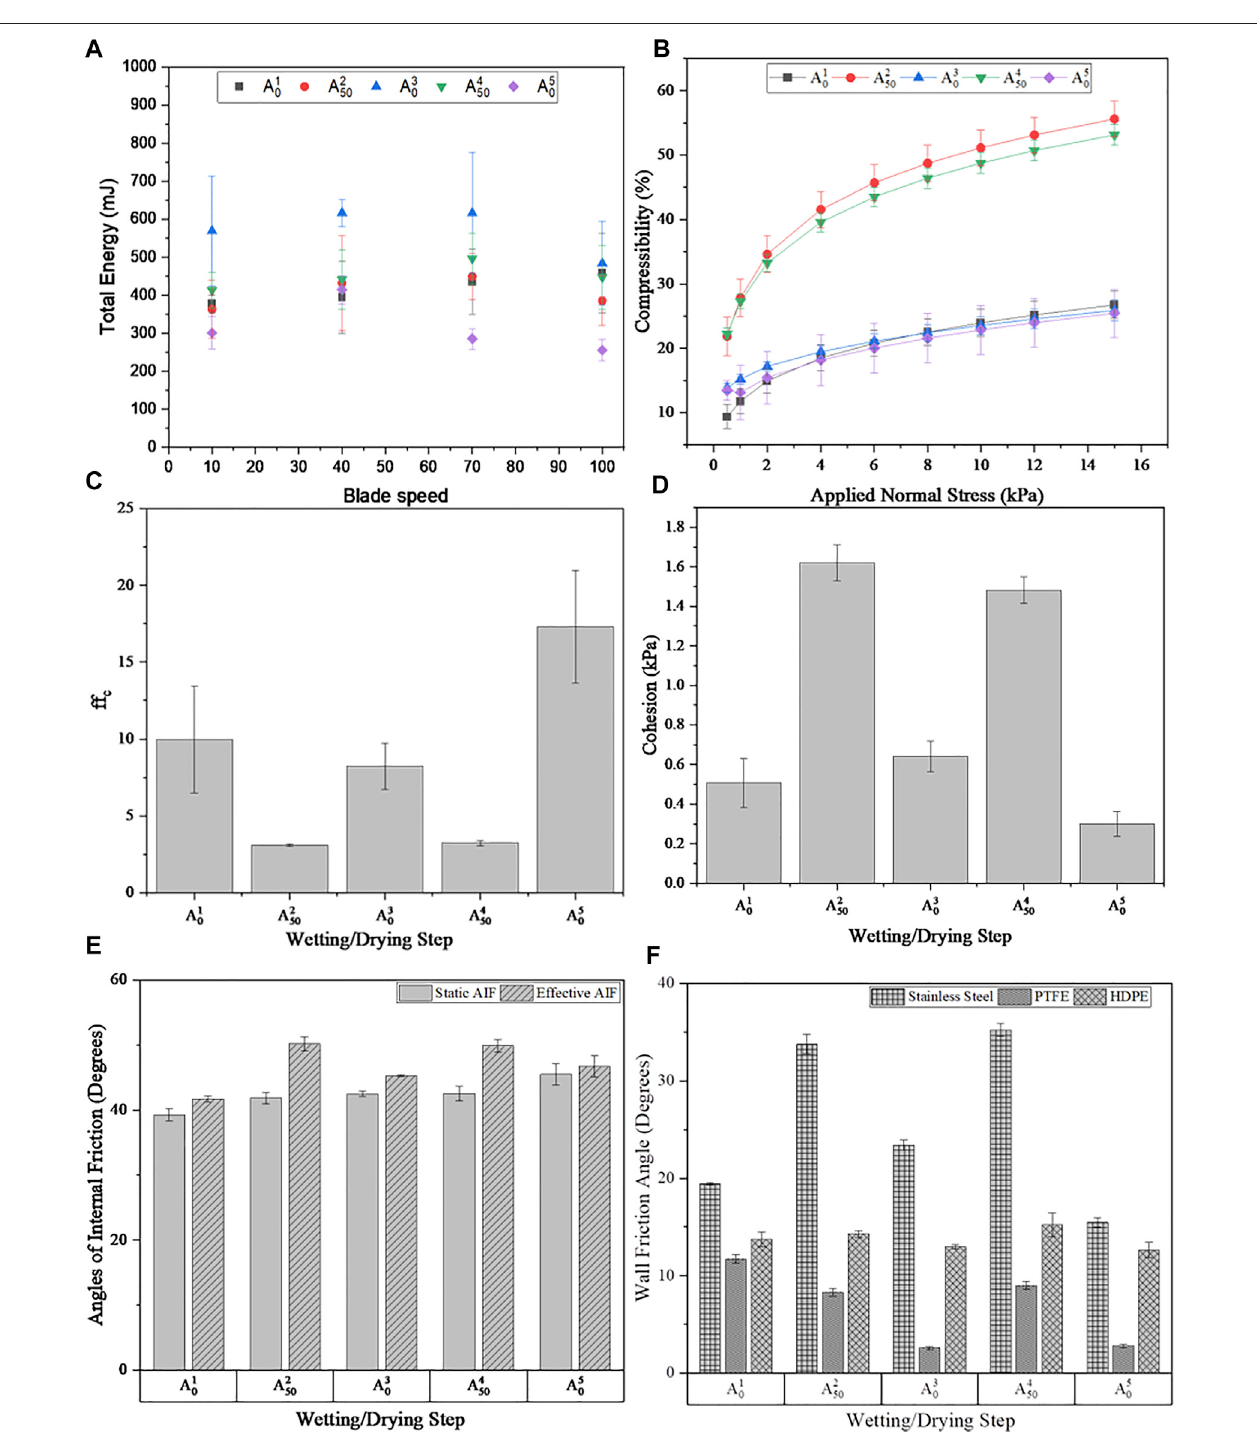
FIGURE 9 | The (A) total energy, (B) compressibility, (C) fl owability factor, (D) cohesion, (E) static and effective angles of internal friction and (F) wall friction angles as a function of repeated wetting/drying of sample A .